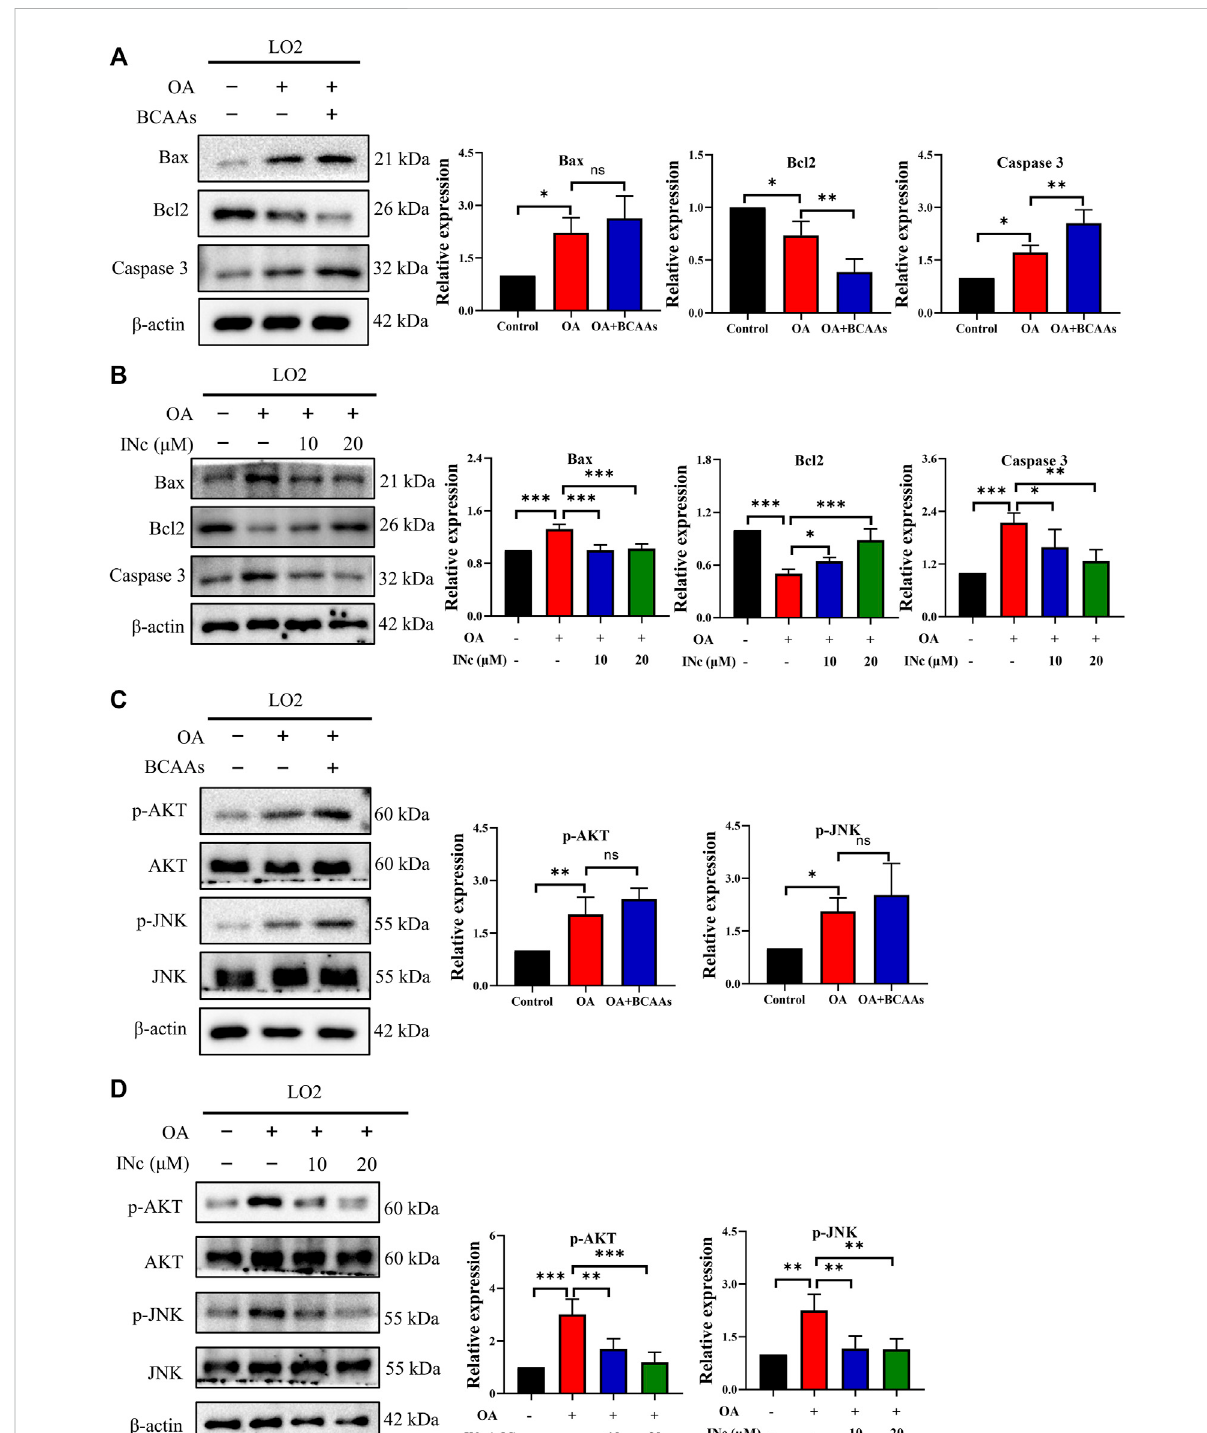
BCATc Inhibitor 2 antagonizes OA-induced activation of Bcl2/Bax/Caspase axis and AKT/JNK signaling. (A – D) LO2 cells were incubated with 0.5 mm Oleic acid with or without 10 mm BCAAs or BCATc Inhibitor 2 for 48 h. Western blot was performed to detect the expression of indicated proteins.Dataareshownasthemean±SDofthreeindependentexperiments.* p < 0.05,** p < 0.01,*** p < 0.001,ns p >